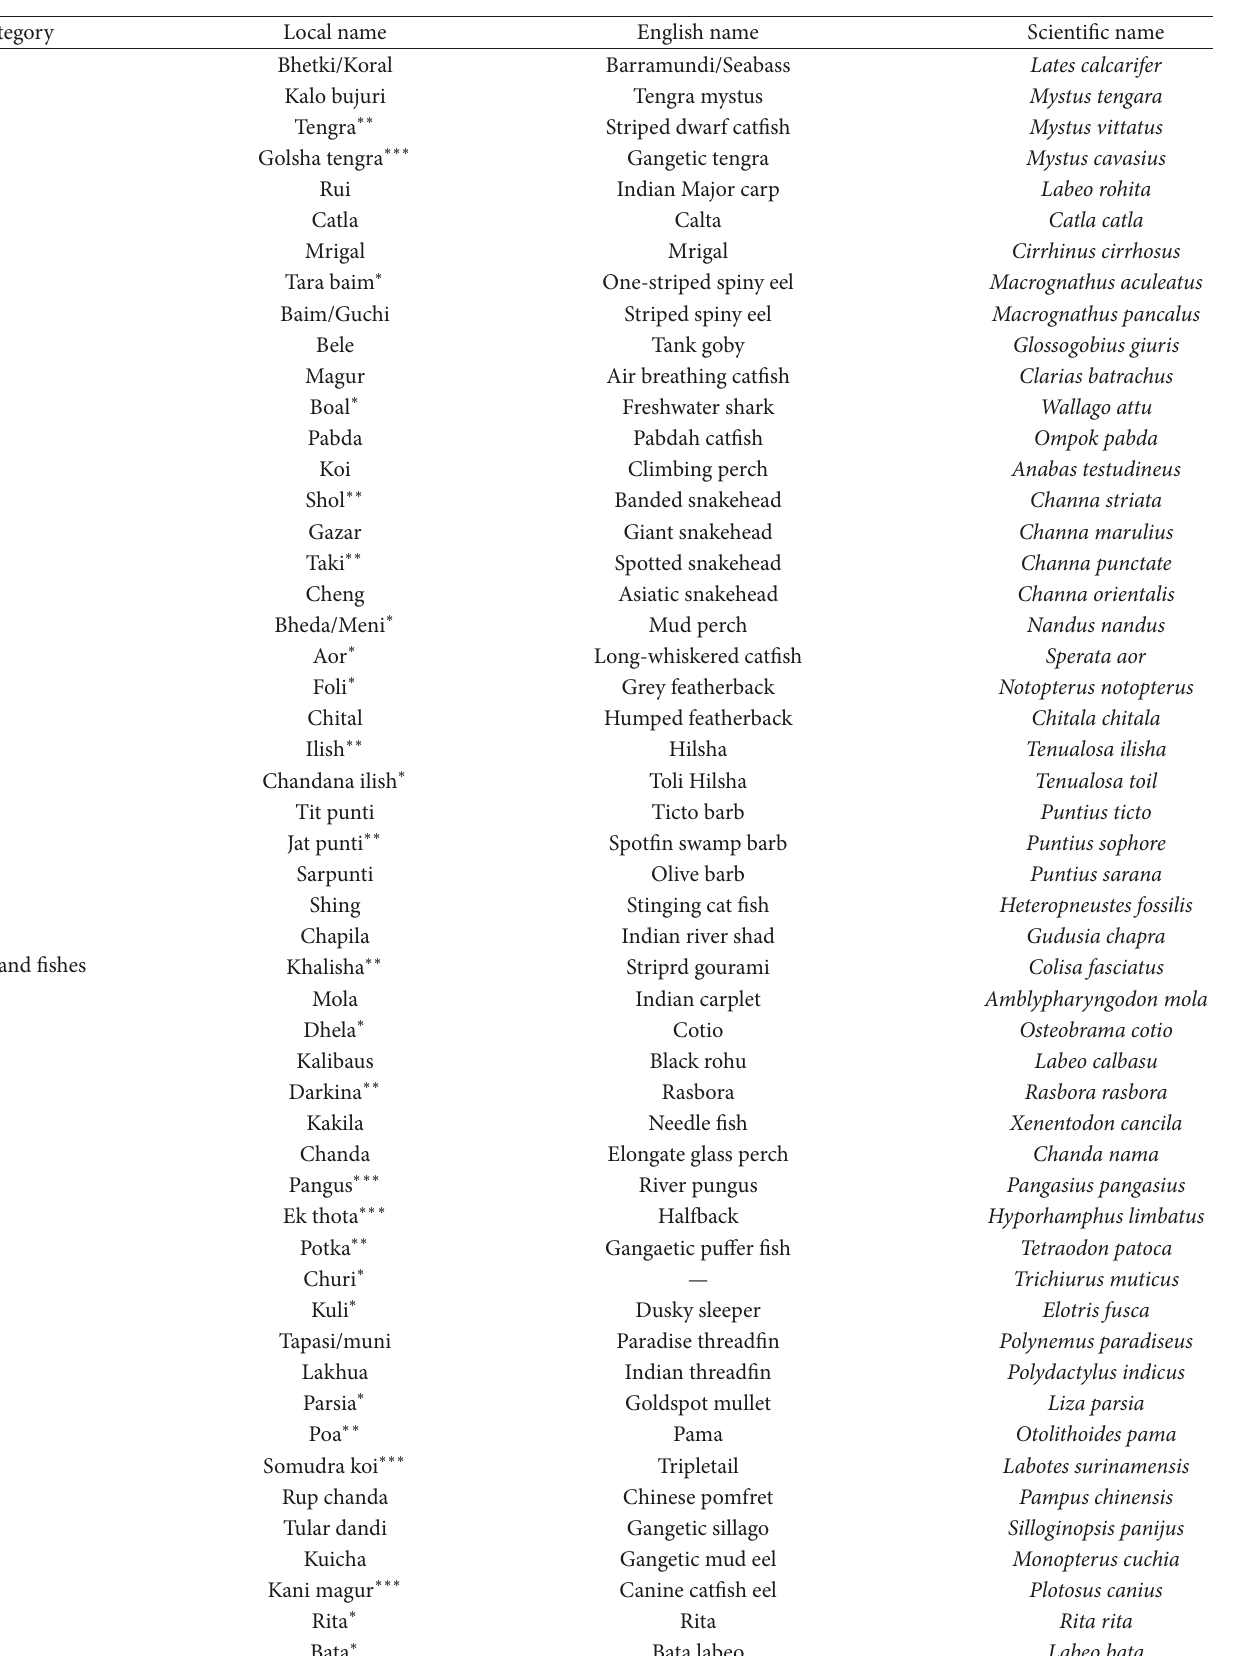
Table 10: Recorded species of fish at Kalapara coastal